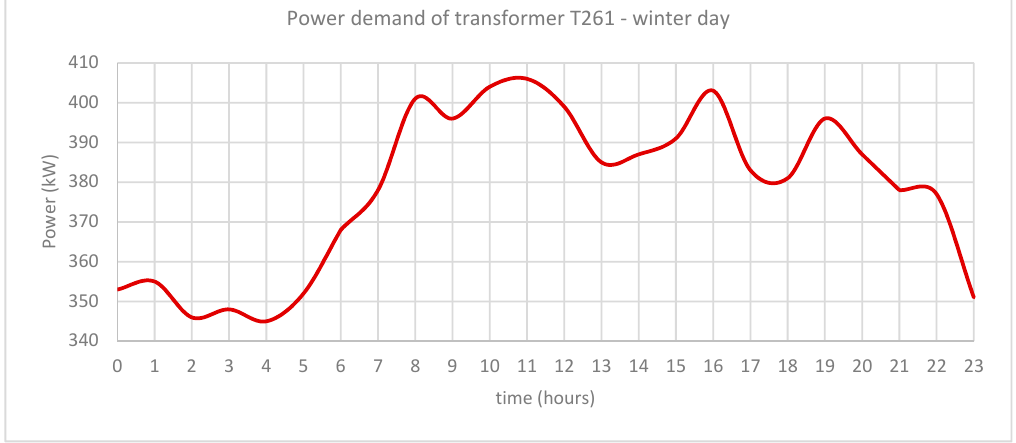
Figure 4. Power demand during the 24 hours.